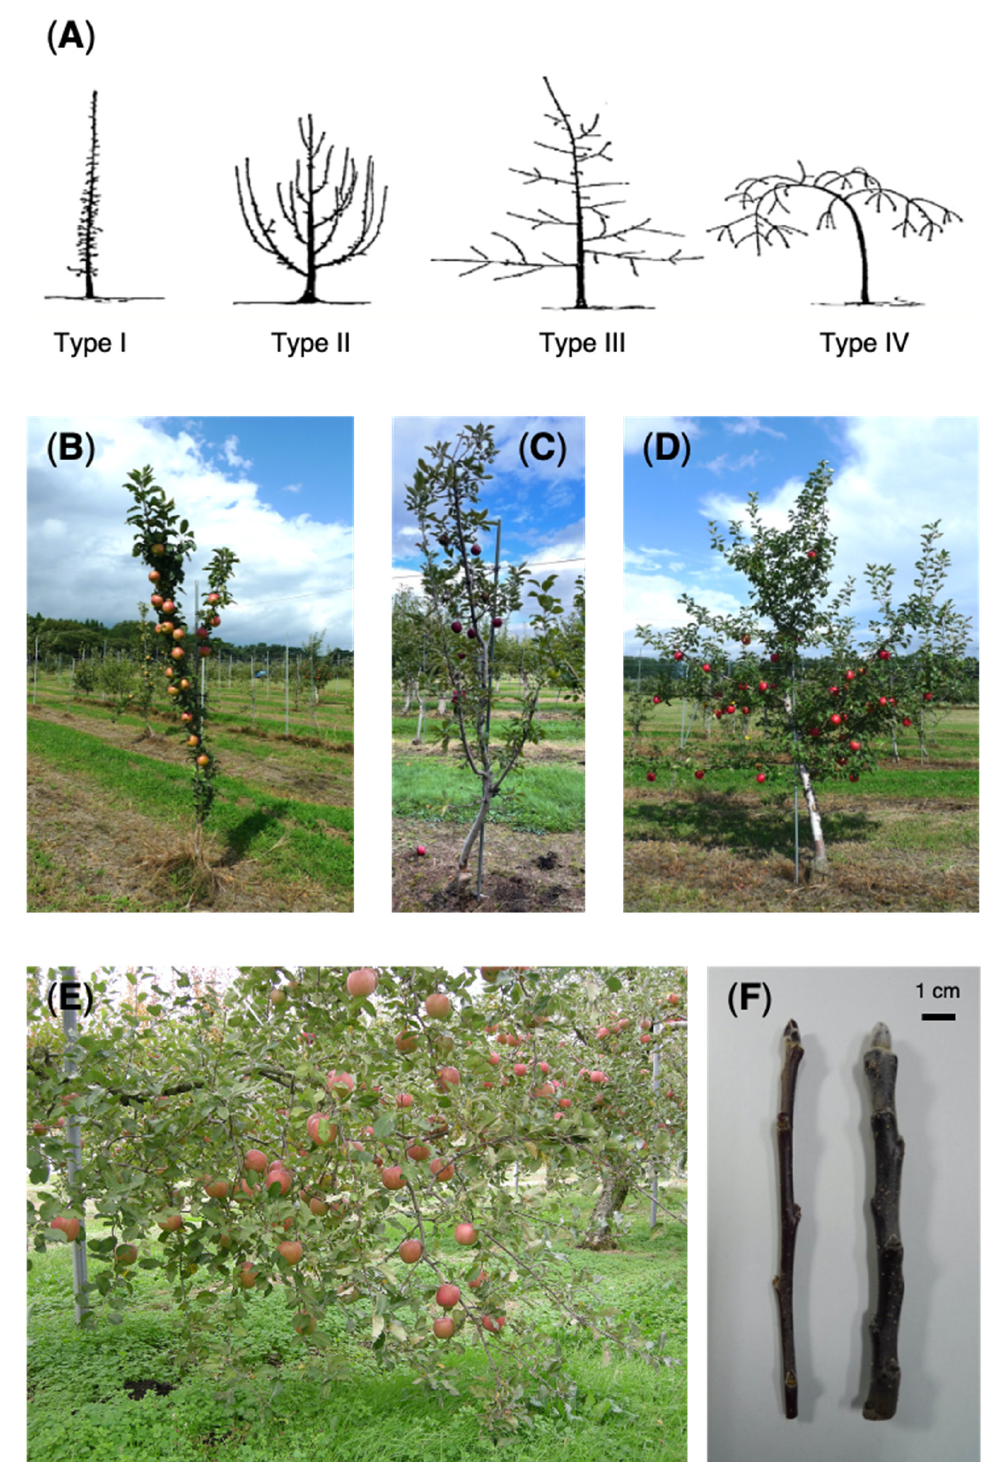
Figure 1. Apple tree architectures and one-year-old branches. ( A ) Tree architectures of four types (type I to IV) of apple; reproduced with permission from Costes et al. [1]. ( B ) Type I (columnar type, seedling); reproduced with permission from Okada [9]. ( C ) Type II (spur type, ‘Wellspur Delicious’). ( D ) Type III (standard type, seedling); reproduced with permission from Okada [9]. ( E ) Type IV (tip-bearing type, ‘Fuji’). ( F ) One-year-old branches of ‘McIntosh’ (left) and ‘McIntosh Wijcik’ (right); reproduced with permission from Okada [10].